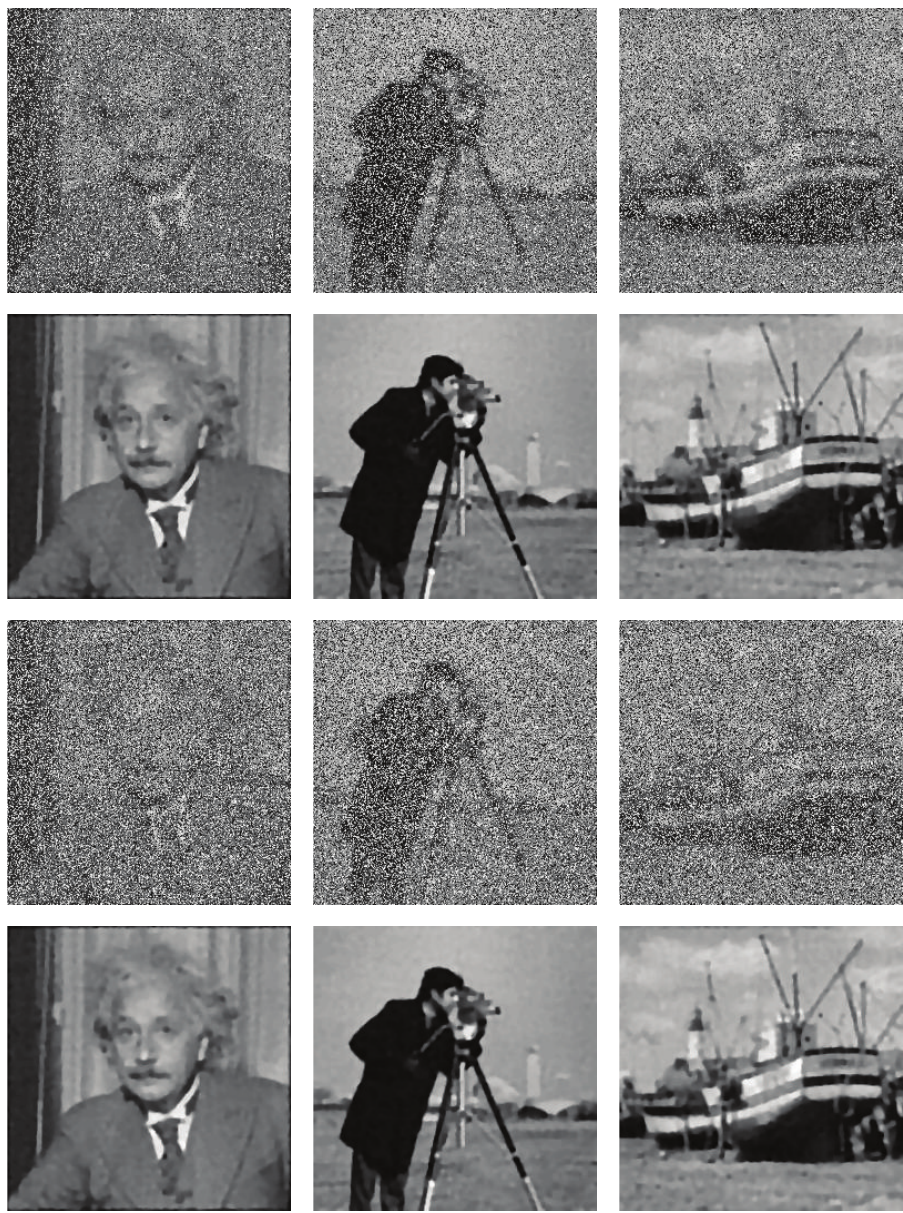
Figure 6: Top: images blurred with out-of-focus kernel of radius 3 and then corrupted by Gaussian noise with 𝜎 = 5 and random-valued noise with 𝑟 = 55 %. The second line: results restored by MNID-ADMM ( 𝛼 1 = 0.9 , 𝛽 1 = 𝛽 2 = 𝛽 3 = 0.05 ). The third line: images blurred with out-of-focus kernel of radius 3, and then corrupted by Gaussian noise with 𝜎 = 5 and random-valued noise with 𝑟 = 7 0%. Bottom: results restored by MNID-ADMM ( 𝛼 1 = 0.9 , 𝛽 1 = 𝛽 2 = 𝛽 3 = 0.05